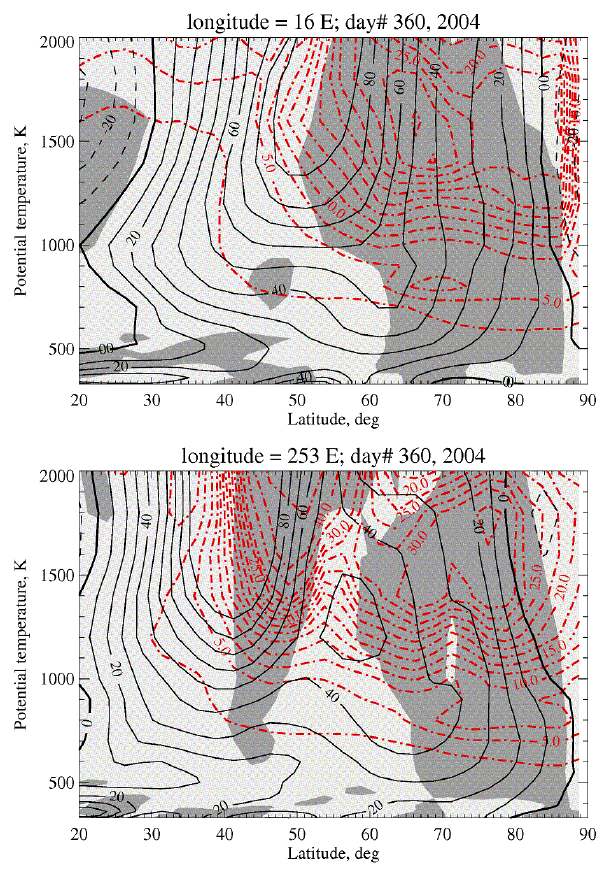
Fig. 5b. The same as Fig. 5a only for 25 February 2005 (day num- ber